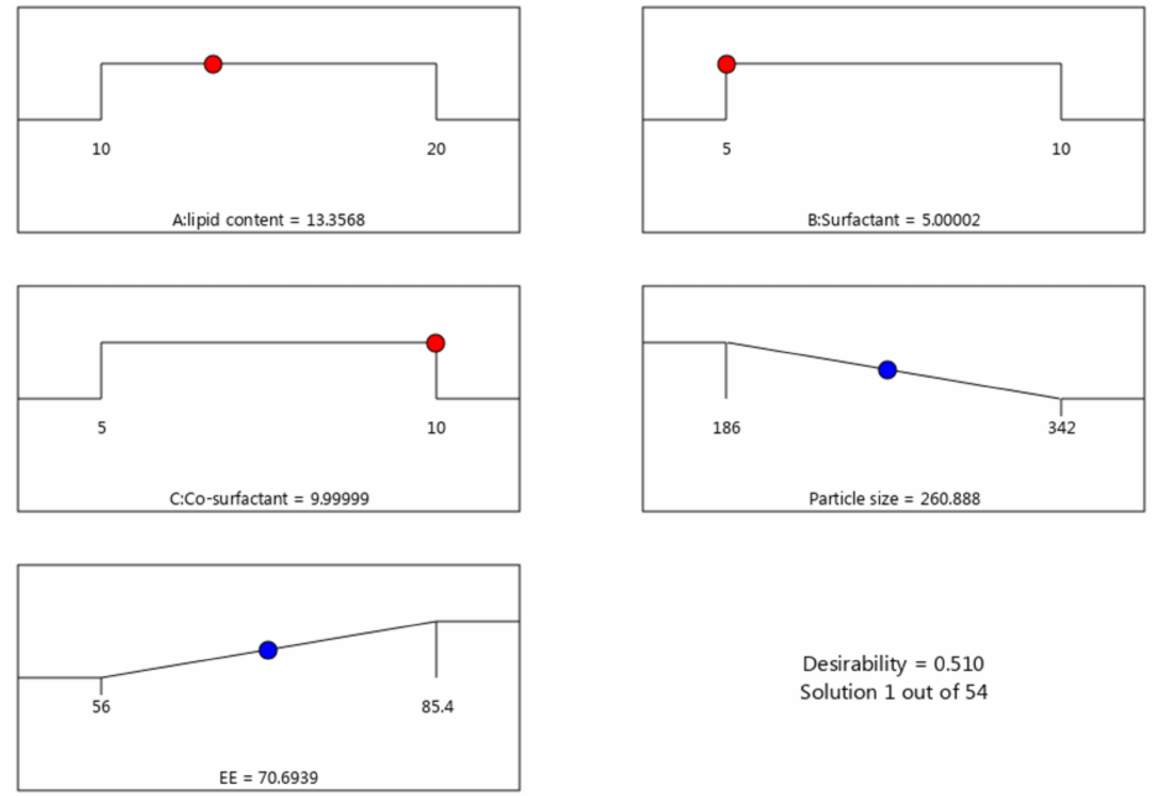
Figure 5. Optimization ramps for the investigated independent variables with their predicted dependent responses and the desirability